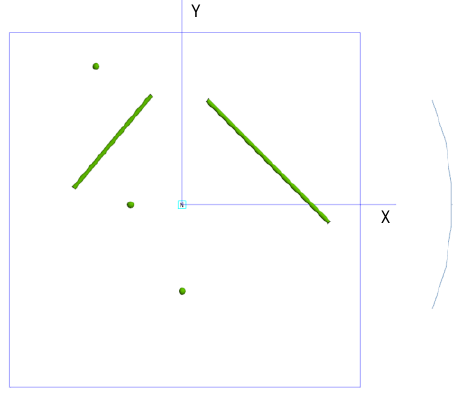
Figure 10. The imaging scene.